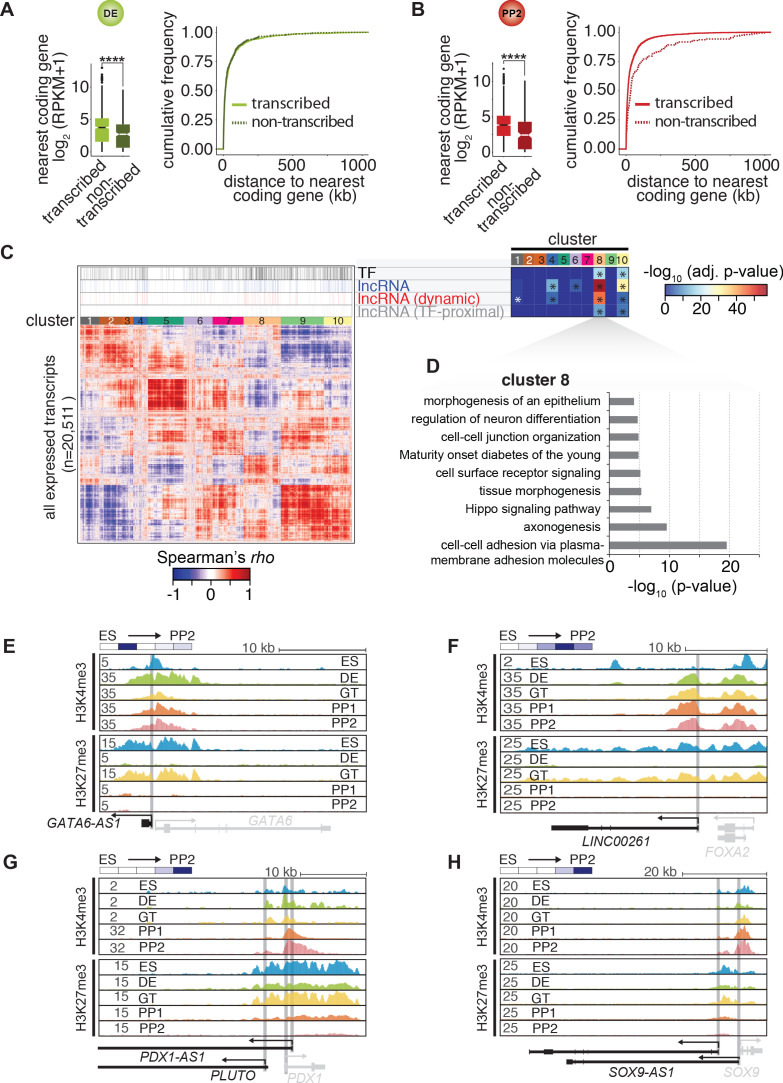
Characterization of lncRNAs expressed during pancreatic differentiation.(A,B) Left: Expression of the single nearest coding genes (±1000 kb) in cis to transcribed and non-transcribed lncRNAs at the DE stage (A) or PP2 stage (B). Log2 transformed mean expression values (RPKM + pseudocount) from two biological replicates were used to generate the box plots (****, p-value<0.0001, Wilcoxon rank sum test). Right: Corresponding cumulative distance distribution functions. (C) Heatmap of the hierarchically clustered expression correlations (Spearman’s rho) of all RNAs transcribed during pancreatic differentiation (with RPKM ≥ 1 in at least ten out of 38 tissues). Transcription factor (TF)-encoding mRNAs, lncRNAs (all), dynamically expressed lncRNAs (RPKM ≤ 1 in at least one stage (ESC to PP2)), and TF-proximal lncRNAs are highlighted above the heatmap. Clusters 8 and 10 are significantly enriched for all of these RNAs (*, p-value<0.03, Fisher test). (D) Gene ontology and KEGG pathway analysis for all coding genes in cluster 8 (p-value<0.05, Fisher test). The full list of significantly enriched terms is shown in Figure 1—source data 1C. (E–H) H3K4me3 and H3K27me3 ChIP-seq tracks of loci containing lncRNAs GATA6-AS1 (A), LINC00261 (B), PDX1-AS1/PLUTO (C), or SOX9-AS1 (D) during pancreatic differentiation of CyT49 hESCs.